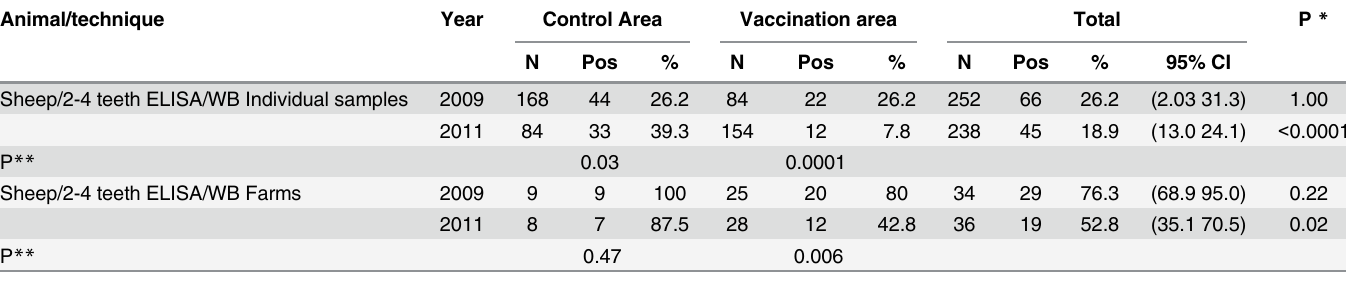
Sheep/2-4 teeth ELISA/WB Individual samples P **